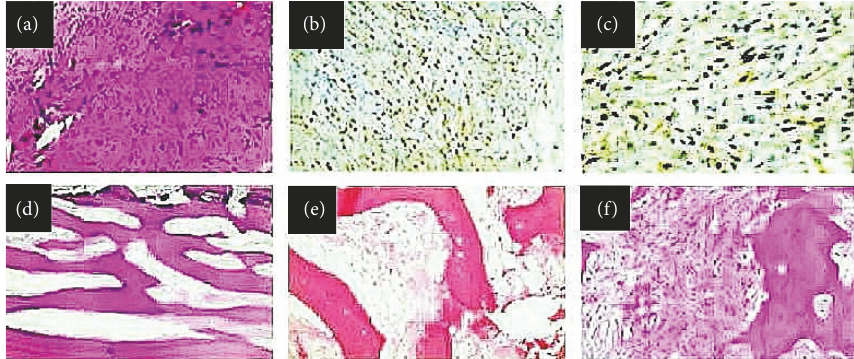
Figure 2: (a) Representative photomicrograph for histological evaluation with hematoxylin-eosin staining (original magnification: 200X): hypocellular tumor with spindle cells showing mild atypia arranged in fascicles in desmoplastic collagenous stroma. The histological results are compatible with parosteal osteosarcoma (PAOS). (b, c) Representative photomicrographs for immunohistochemical assessment displaying tumor cells positively immunostained for MDM-2 (original magnification: 400X) and CDK4 (original magnification: 400X), respectively, with nuclear location. (d) Representative photomicrograph of the slices for histological evaluation after tumor excision with hematoxylin-eosin staining (original magnification: 200X): parallel trabeculae of the well-formed woven bone with spindle neoplastic cells in collagenous stroma, while (e) the neoplastic population is characterized by mild cellularity and atypia (original magnification: 40X). (f) Representative photomicrograph for histological evaluation with hematoxylin-eosin staining showing clusters of moderate cellularity and moderate atypia in PAOS (original magnification: